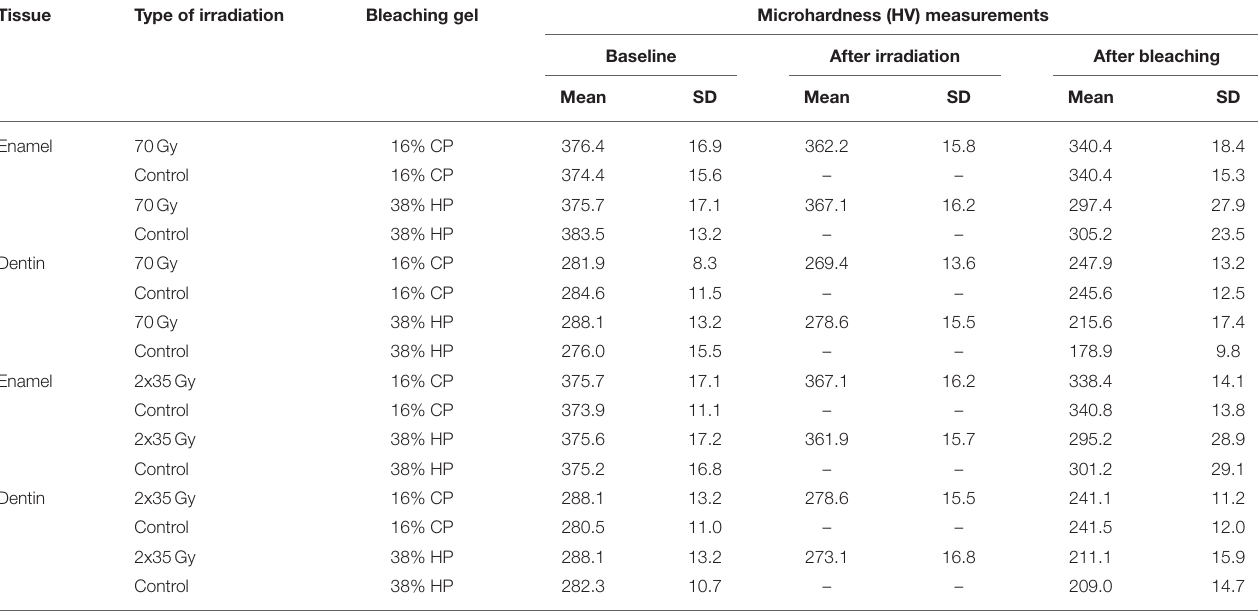
TABLE 2 | Summary of baseline, irradiation, and bleaching measurements of enamel and dentin Vickers microhardness (HV) across different treatment groups.